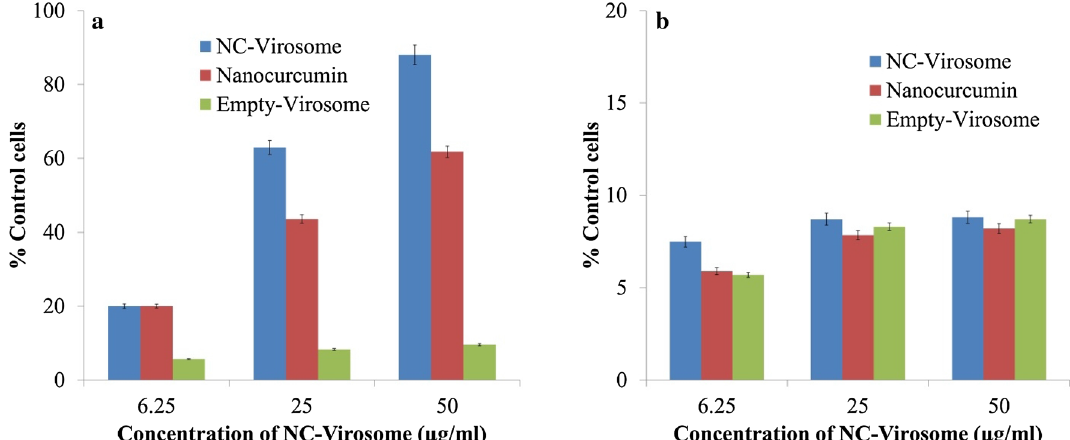
Figure 7. ( a ) The graph showing % cell growth control with the different concentrations of the nanocurcumin, empty-virosome, and NC-virosomes on MDA-MB231 cells at 48 h. ( b ) The graph showing % cell growth control with the different concentrations of the nanocurcumin, empty-virosome, and NC-virosomes on MSCs cells. The statistical analysis was performed through students’ t-test, # P ˂ 0.05, ## ˂ 0.001 compared to control. The error bar represents standard error among the observations. The data were performed in triplicate.